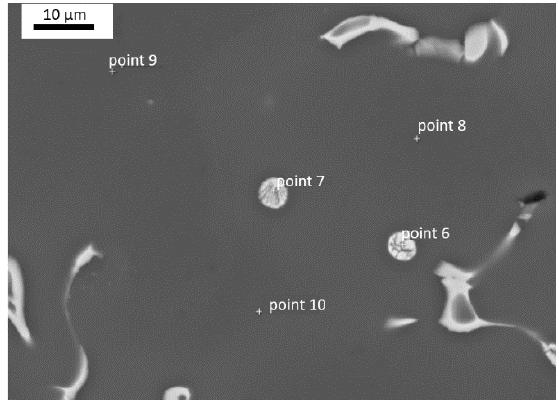
Figure 3. SEM image of Mg5Zn0.3Ca. EDS was carried out at well ‐ defined points (here #6–#10) on the sample’s surface. Mainly, the primary precipitates were investigated, but so was the surrounding matrix.